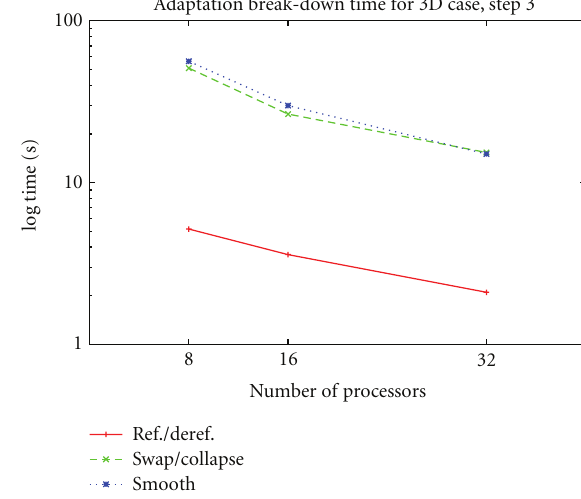
Figure 23: Execution time for adaptation blocks on multiple proc- essors. 3D wedge, first adaptation step.